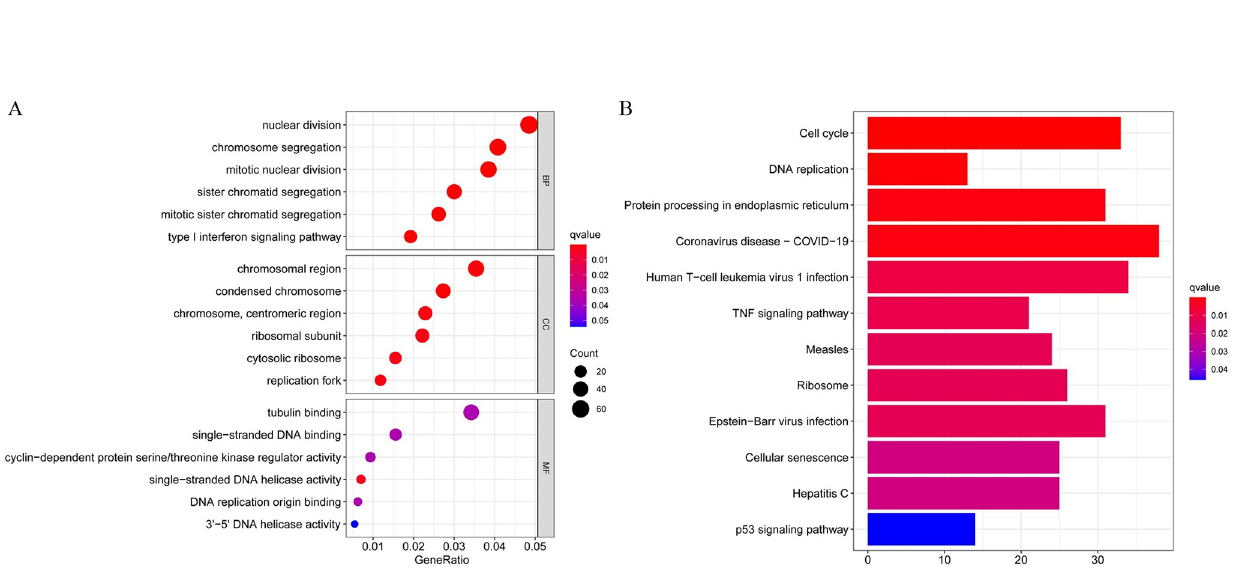
Fig 4. The GO enrichment analysis and KEGG pathways analysis of GSE38246. Abbreviation: GO, Gene Ontology; KEGG, Kyoto Encyclopedia of Genes and Genomes; DEGs, differentially expressed genes.